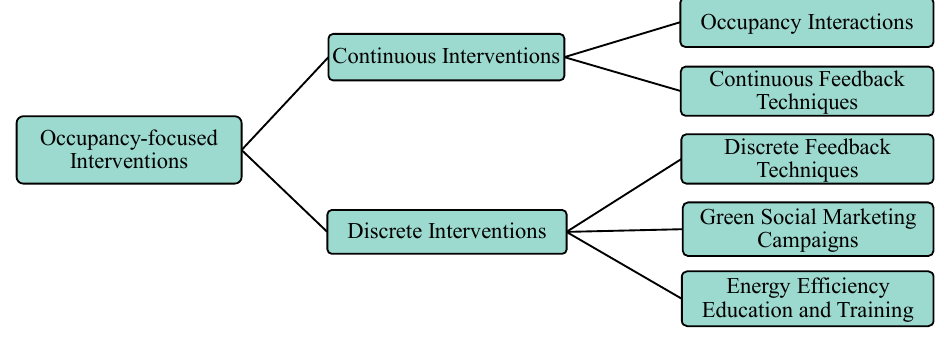
Figure 3. Occupancy-focused interventions for improving energy-use behaviors